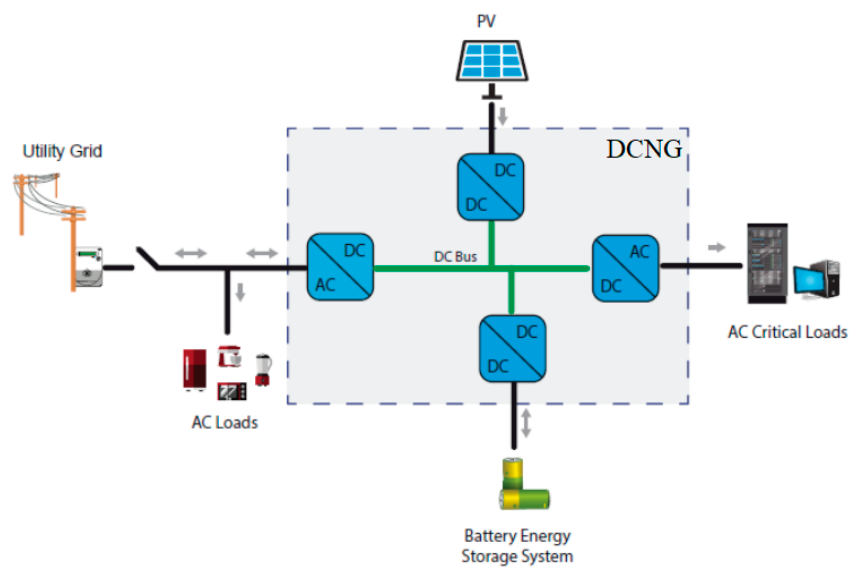
Figure 4. DCNG base module.